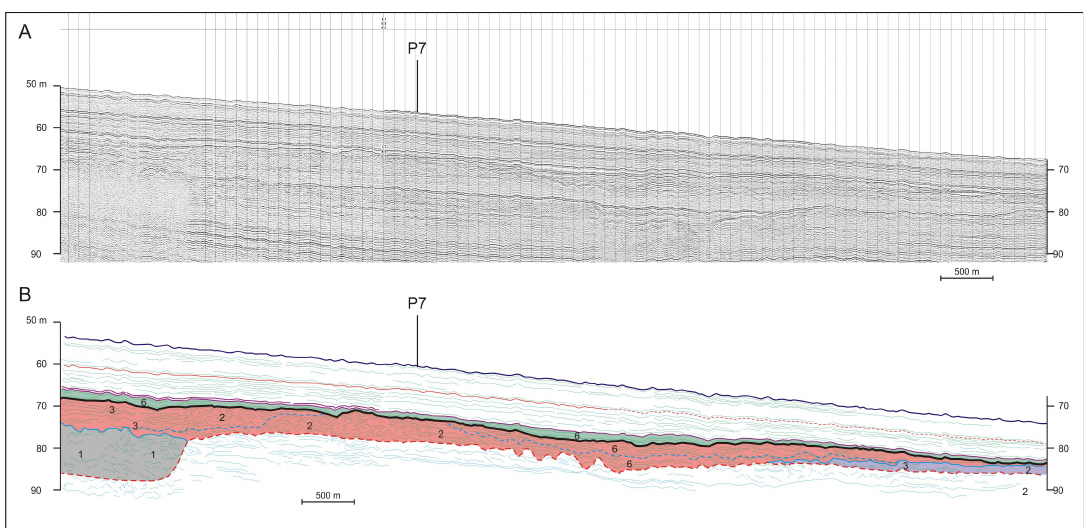
Figure 8. Part of seismic profile T3. Seismic section ( A ) and interpretation ( B ) showing, among others, units B m with its subunits arranged in a continuous landward backstepping pattern.